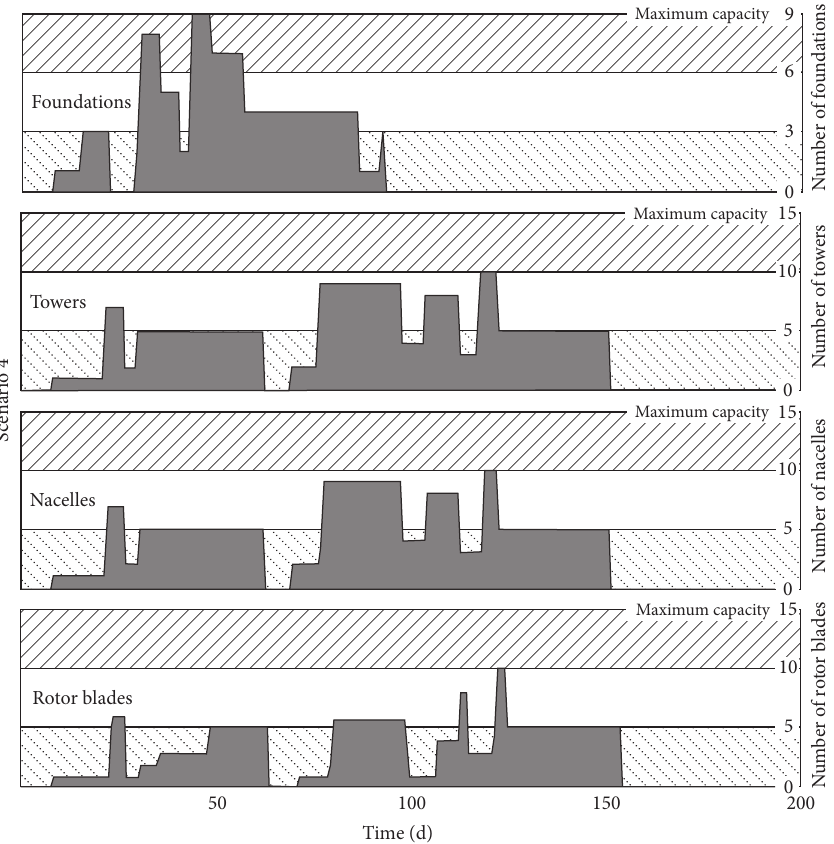
Figure 7: Simulation results of Scenario